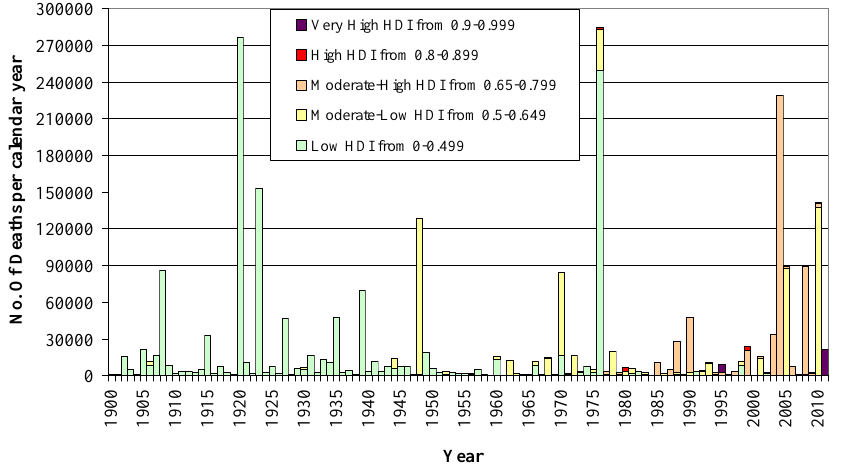
Fig. 9. CATDAT v5.024 Damaging Earthquakes – best estimate of yearly deaths for damaging earthquake and secondary effect events from